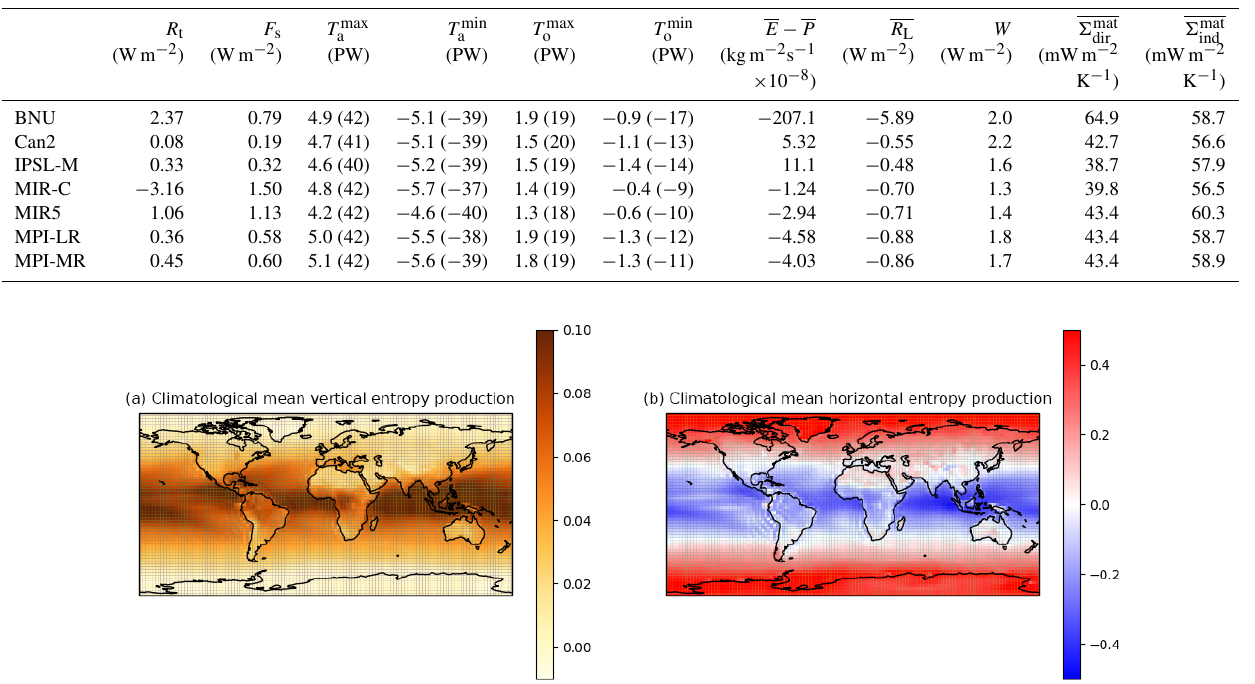
Figure 6. Climatological annual mean maps of (a) the vertical component of material entropy production (Wm − 2 K) and (b) the horizontal component of material entropy production (Wm − 2 K) for a 20-year pre-industrial CanESM2 model